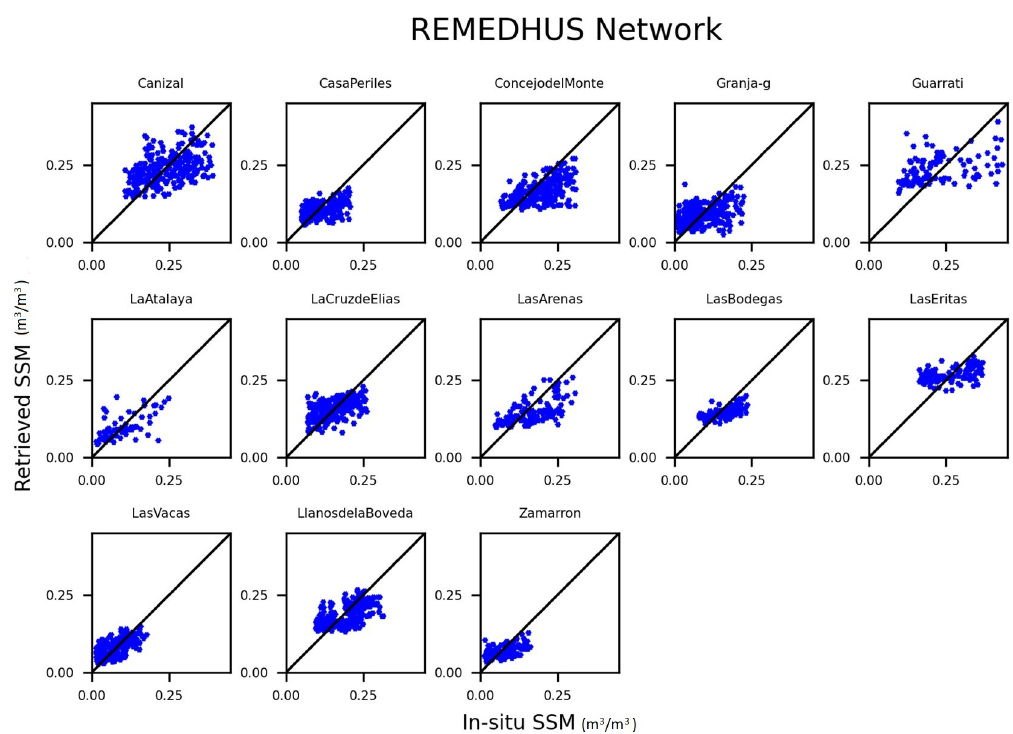
Figure 5. Scatterplots of the estimated soil moisture as a function of ISMN measurements in the REMEDHUS network per considered station.